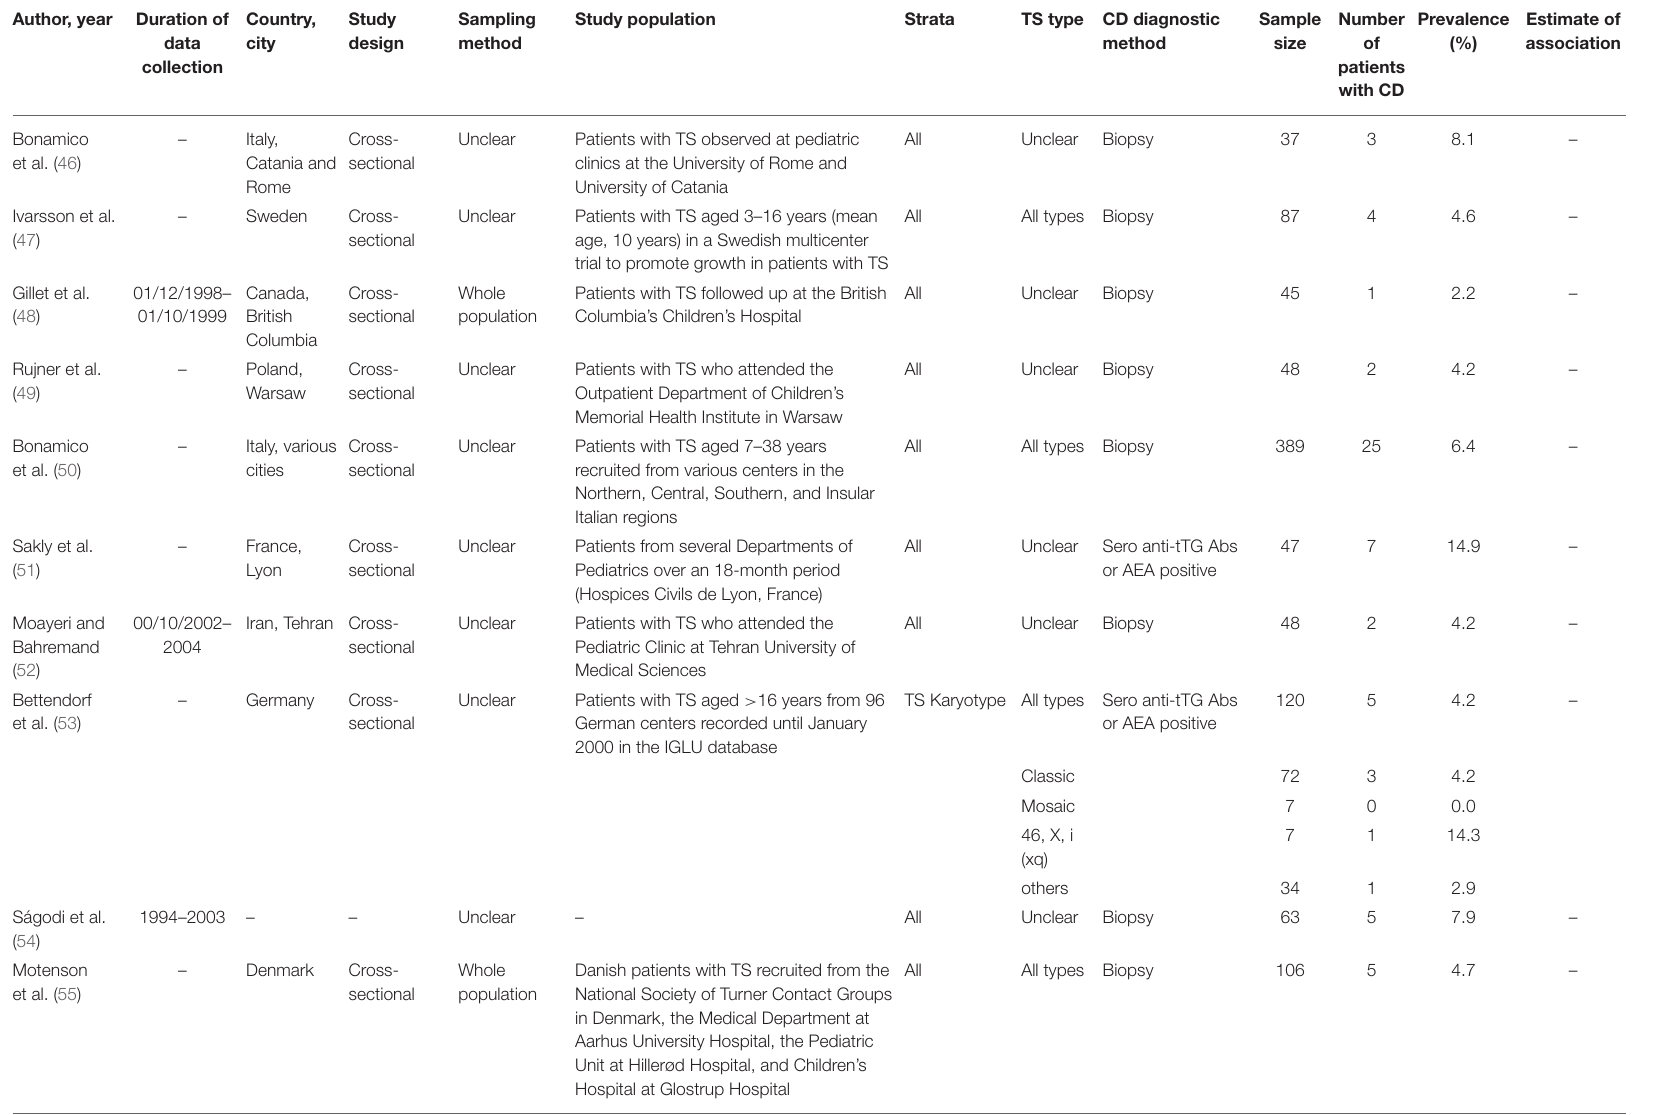
TABLE 1 | Summary of studies reporting the prevalence of CD in patients with TS and/or association between TS and